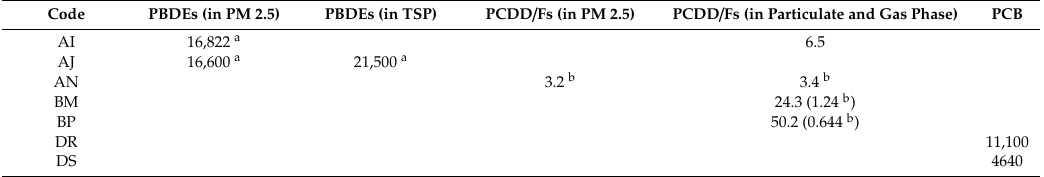
Table 10. Concentration of organic pollutants in air samples (values expressed in pg / m 3